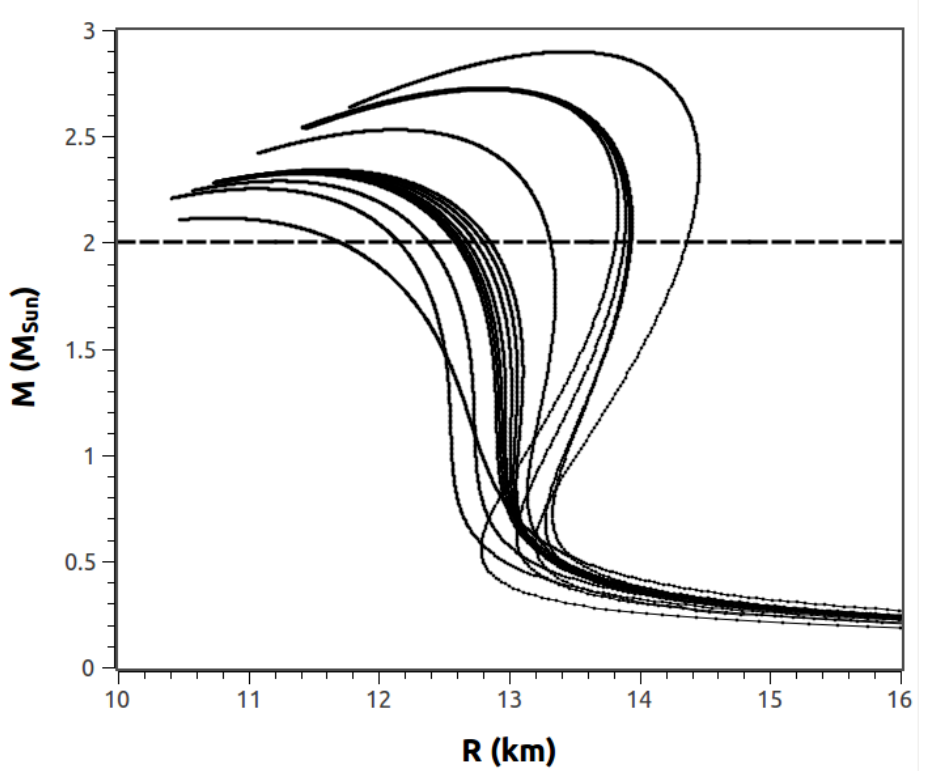
Figure 2. Mass–radius relations corresponding to the equations of state plotted in Figure